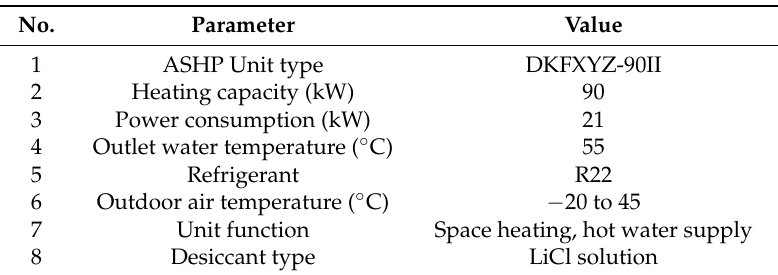
Table 17. Main parameters of the selected ASHP unit